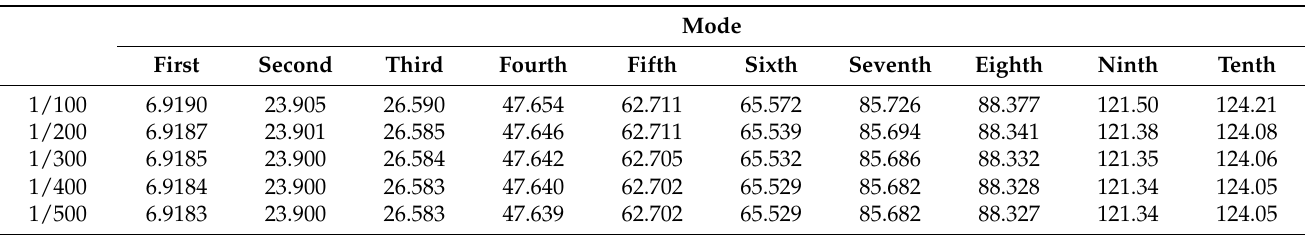
Table 1. Convergence of the dimensionless frequency parameter φ obtained by FEM for the CCFF square plates with different mesh